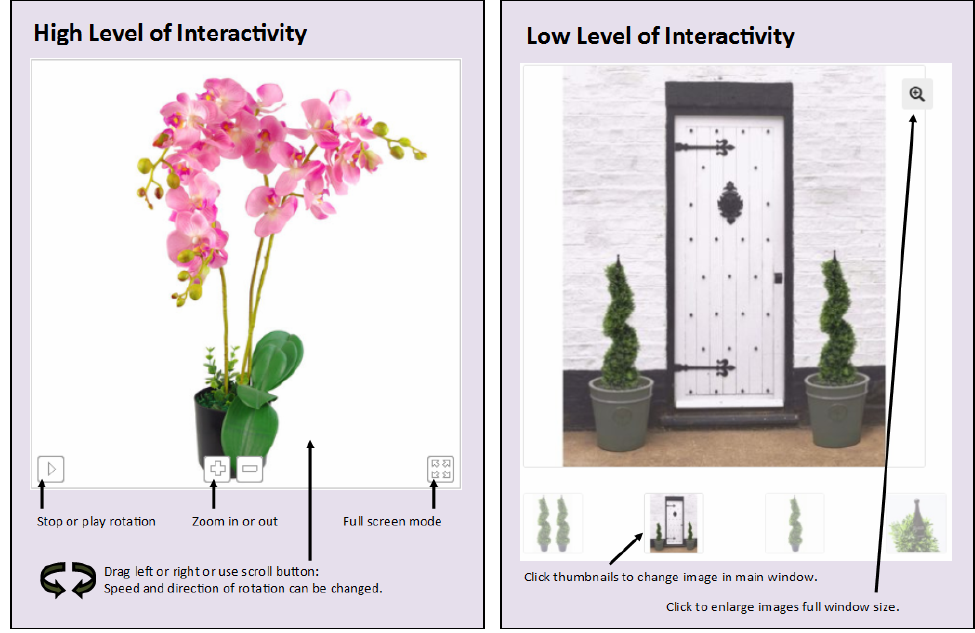
Figure 1. Interactivity level high/low.